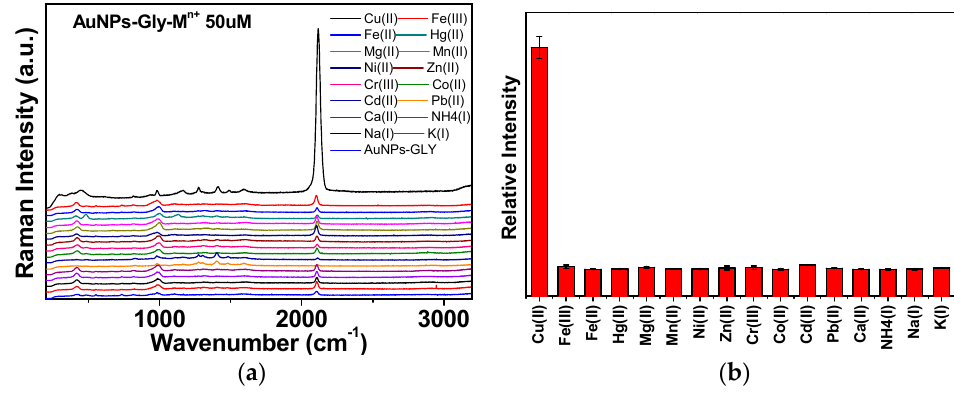
Figure 4. ( a ) SERS spectra of GLY in the presence of 50 µM of various ions. The SERS spectrum of GLY on AuNPs is presented in the middle. Only the Cu 2+ ion could induce a strong CN peak as listed at the top of the spectra; ( b ) Stick diagram of the relative intensities of the CN bands for the tested ions. Three independent measurements were performed to yield the error bars in order to check the reproducibility.